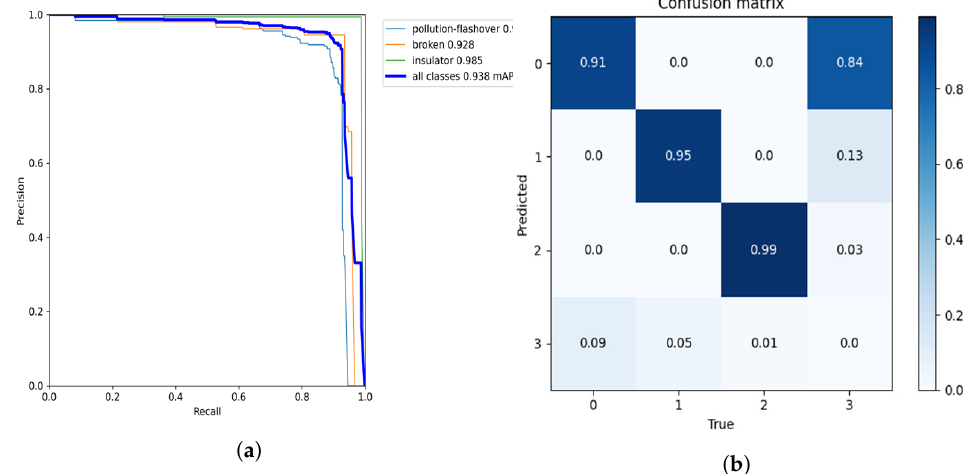
Figure 12. Operation result curves of this model: ( a ) precision–recall curve; ( b ) confusion matrix.